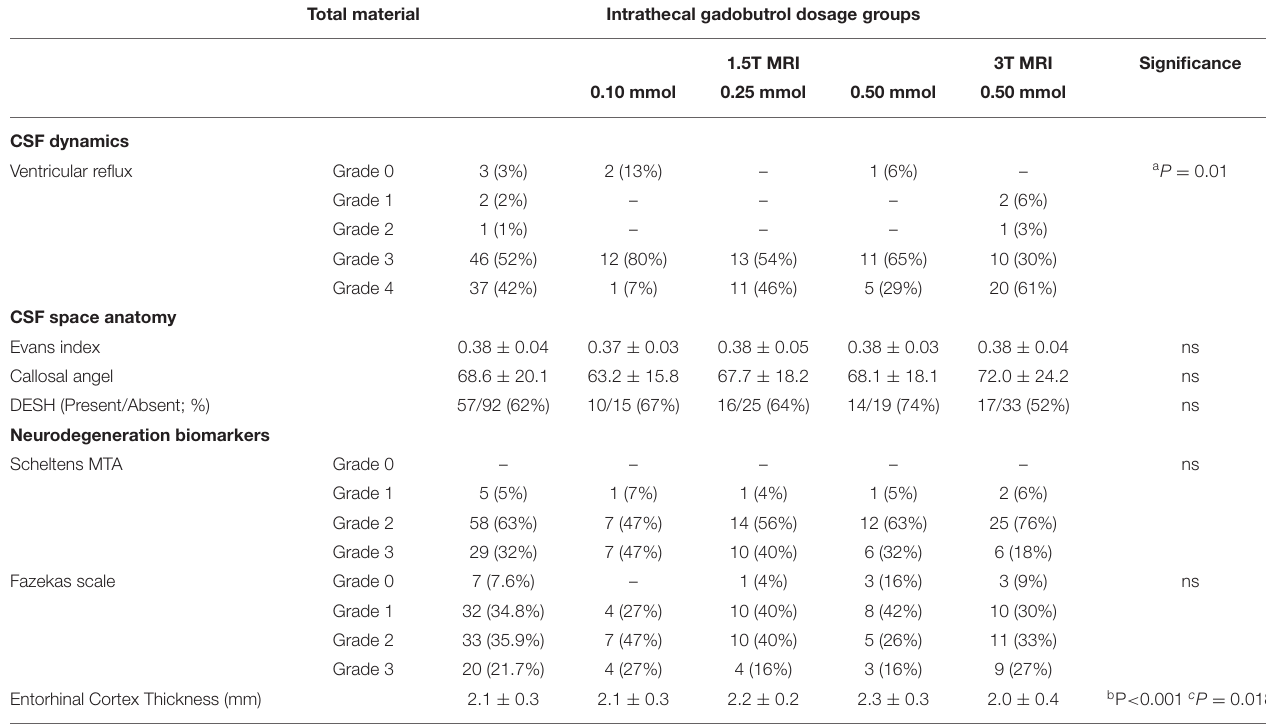
TABLE 2 | MRI biomarkers of CSF dynamics, ventriculomegaly and neurodegeneration for the different treatment